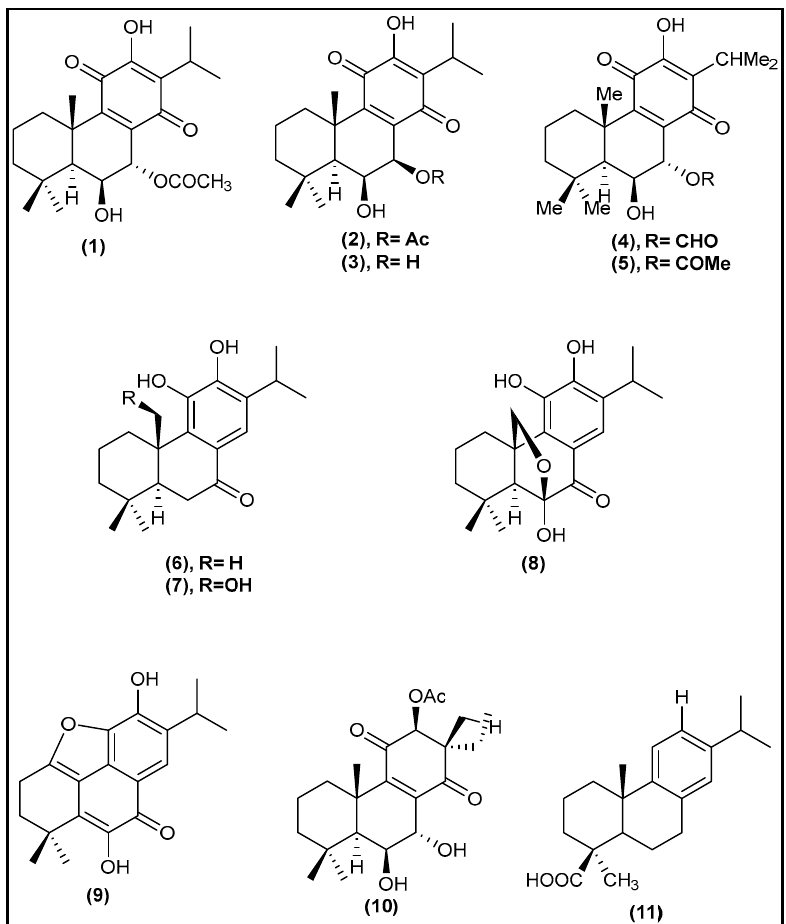
Figure 1. Chemical structures of 7 α -acetoxy-6 β -hydroxyroyleanone (Roy, 1 ), its isomer 7 β -acetoxy- 6 β -hydroxyroyleanone ( 2 ), 6 β ,7 β -dihydroxyroyleanone (DiRoy, 3 ), 7-formyloxy-6ß,12-dihydroxy- abieta-8,12-diene-11,14-dione ( 4 ), 7 α -acetoxy-6ß,12-dihydroxy-abieta-8,12-diene-11,14-dione ( 5 ), 11- hydroxysugiol ( 6 ), 11,20-dihydroxysugiol ( 7 ), carnosolon ( 8 ), 1,11-Epoxy-6,12-dihydroxy-20-norabieta-1(10),5,8,11,13-pentaen-7-one ( 9 ), coleone P ( 10 ), and callistric acid ( 11 ) .